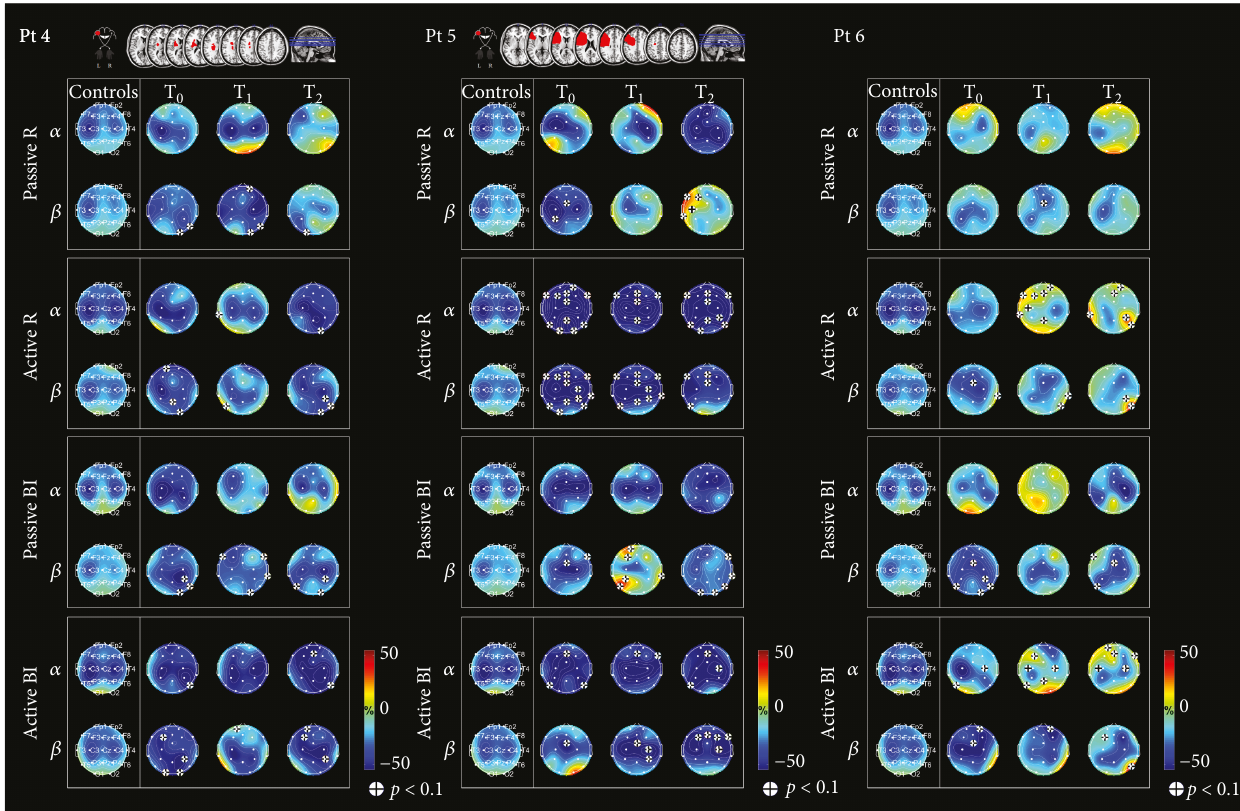
Figure 2: Lesions displayed on a magnetic resonance imaging brain template and topographic maps showing ERD/ERS values. ERD/ERS maps in the alpha and beta bands during passive and active movements with the a ff ected hand and during bimanual passive and active movements (patient numbers 4, 5, and 6). Blue indicates maximal ERD. The t -test was applied individually for each patient in order to compare the ERD/ERS map of each patient to the mean ERD/ERS map of the controls ( p < 0 1 (| t | > 1.895) indicated by